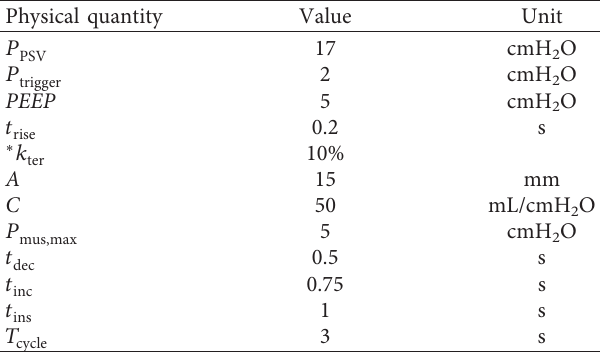
Table 2: The settings of simulation